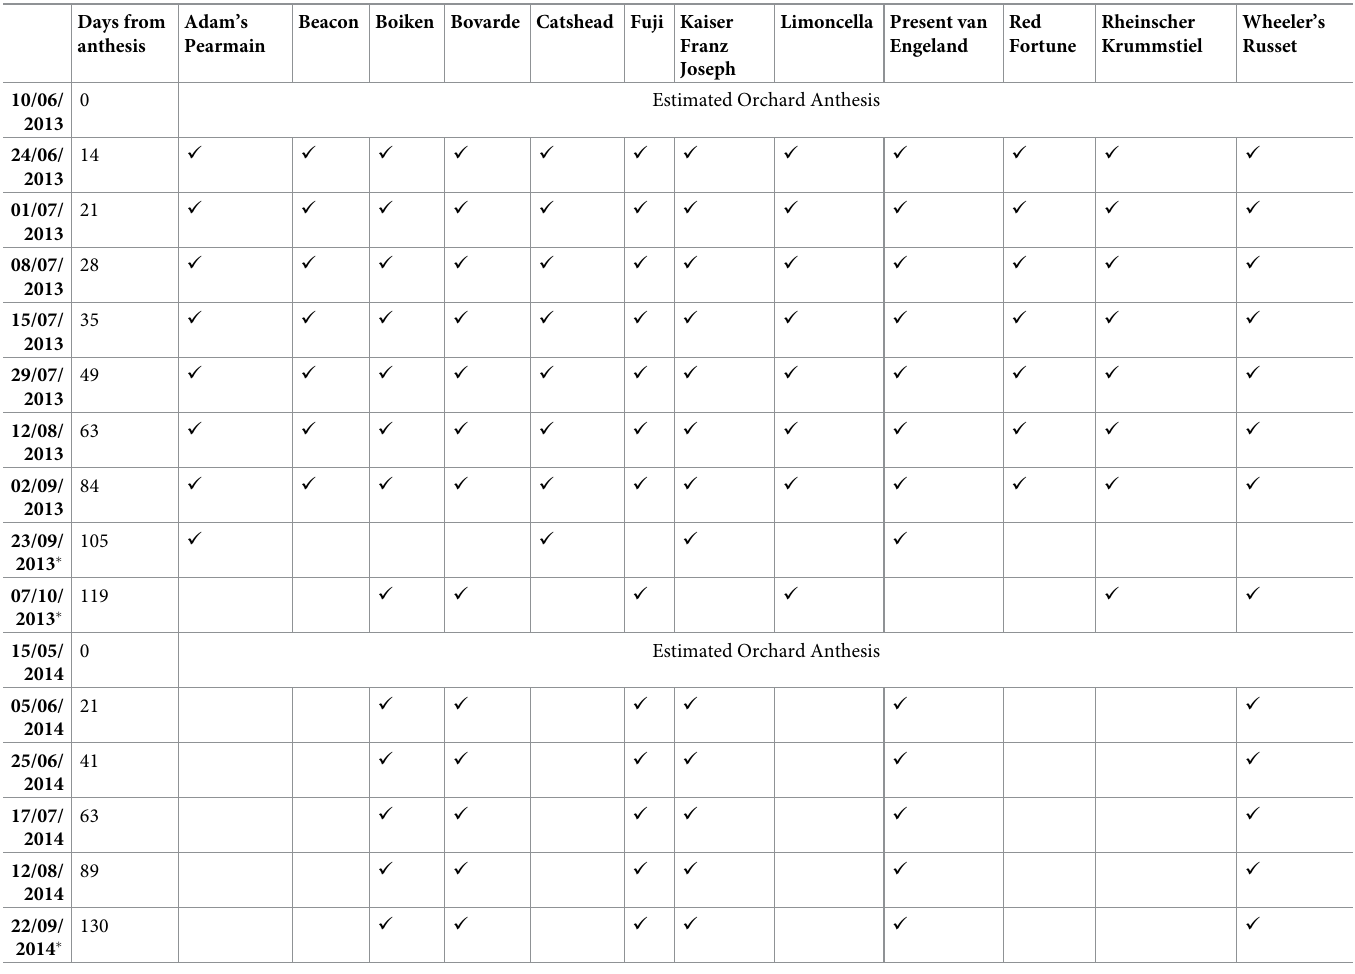
Table 3. Sampling dates per